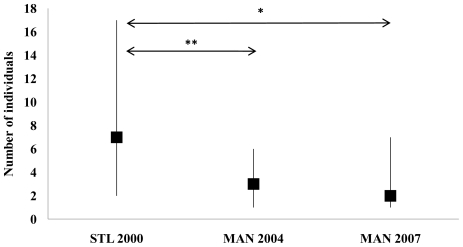
Group size at the two study sites during the three years of data recording.Values are medians and ranges. STL: Sainte Luce; MAN: Mandena. * p<.05; ** p<.001.